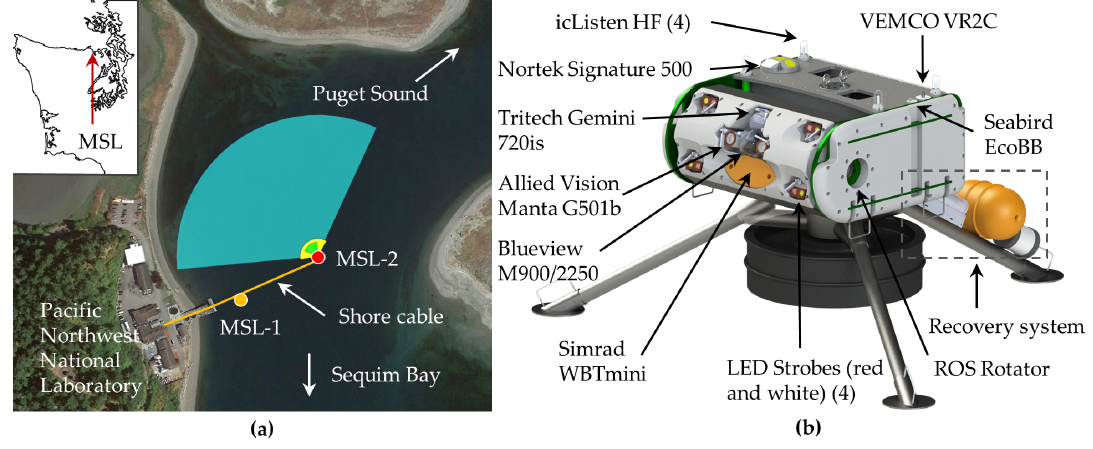
Figure 7. MSL-2 deployment showing ( a ) site layout and ( b ) AMP